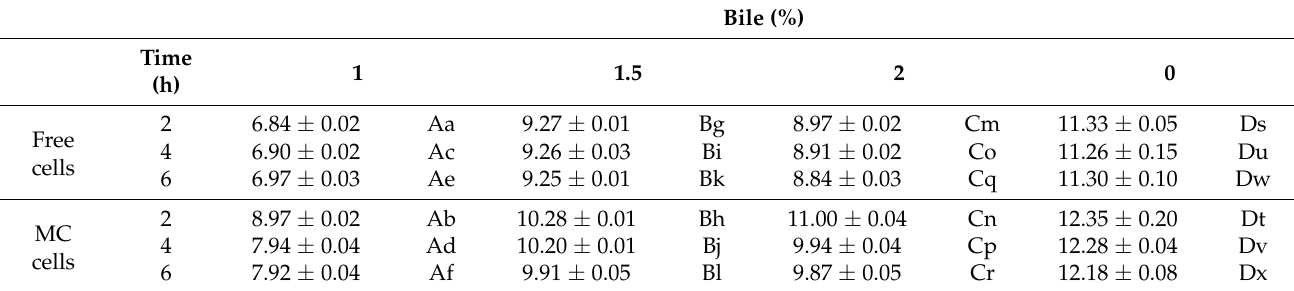
Table 2. Effect of bile salt on the viability of free and microencapsulated (alginate+xanthan gum) L. rhamnosus microcapsules (log cfu mL − 1 ).